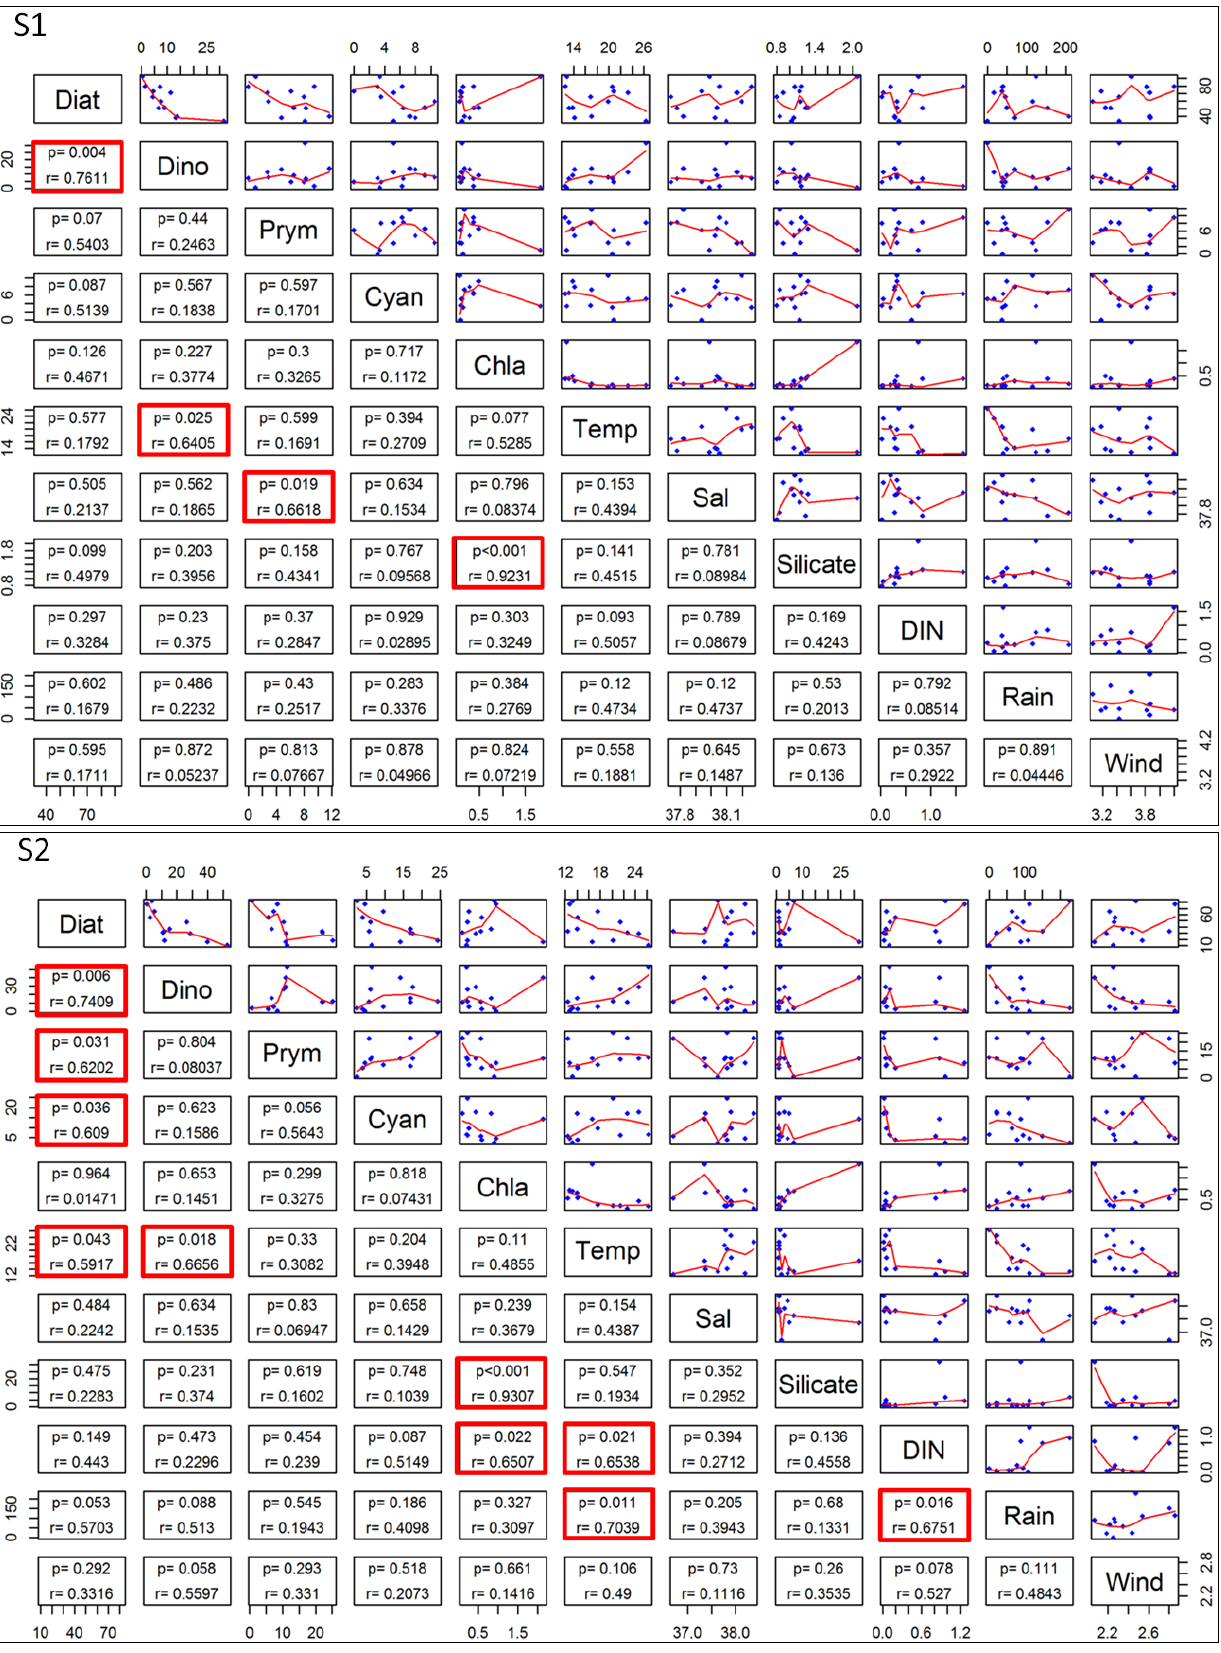
Figure 9. Pair-plots and spearman rank-correlation for dominant taxonomic groups and environmental parameters. Significant correlations are framed in